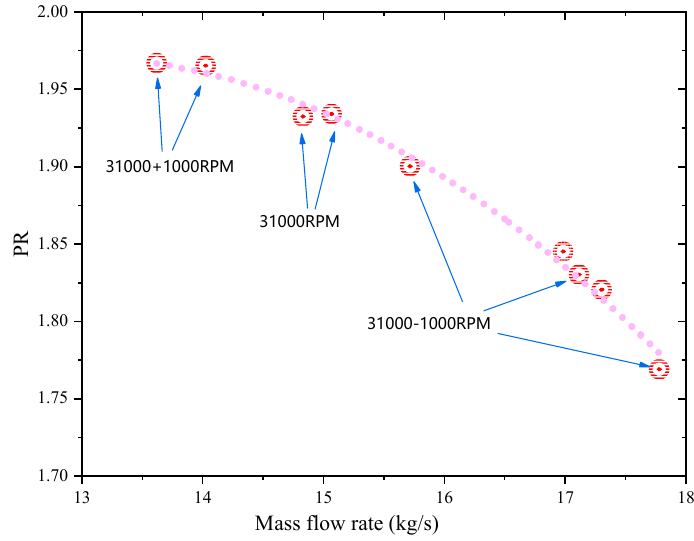
Figure 10. Pressure ratio performance curve (@ 31,000 ± 1000 RPM).